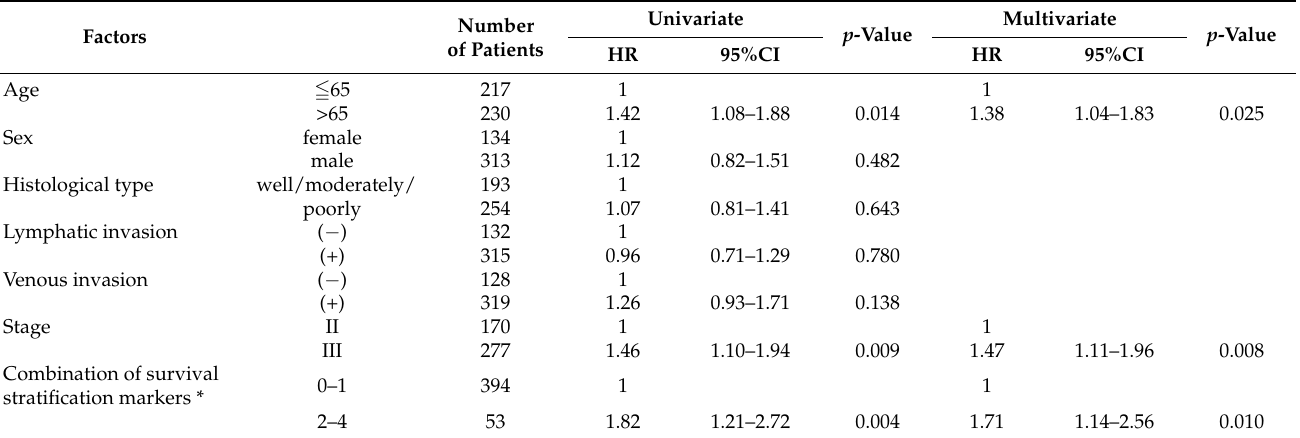
Figure 4. Overall survival rate (OS) of stage II/III gastric cancer (GC) patients according to the combination of survival risk stratification marker expression. A combination of inhibin subunit beta A (INHBA), matrix metallopeptidase-11 (MMP11), platelet-derived growth factor receptor-beta (PDGFRB), and galectin-10 ( a ), and a combination of secreted protein acidic and rich in cysteine (SPARC), INHBA, MMP11, and galectin-10 ( b ) are shown. Table 5. Univariate and multivariate analyses of clinicopathological factors and risk stratification markers expression for overall